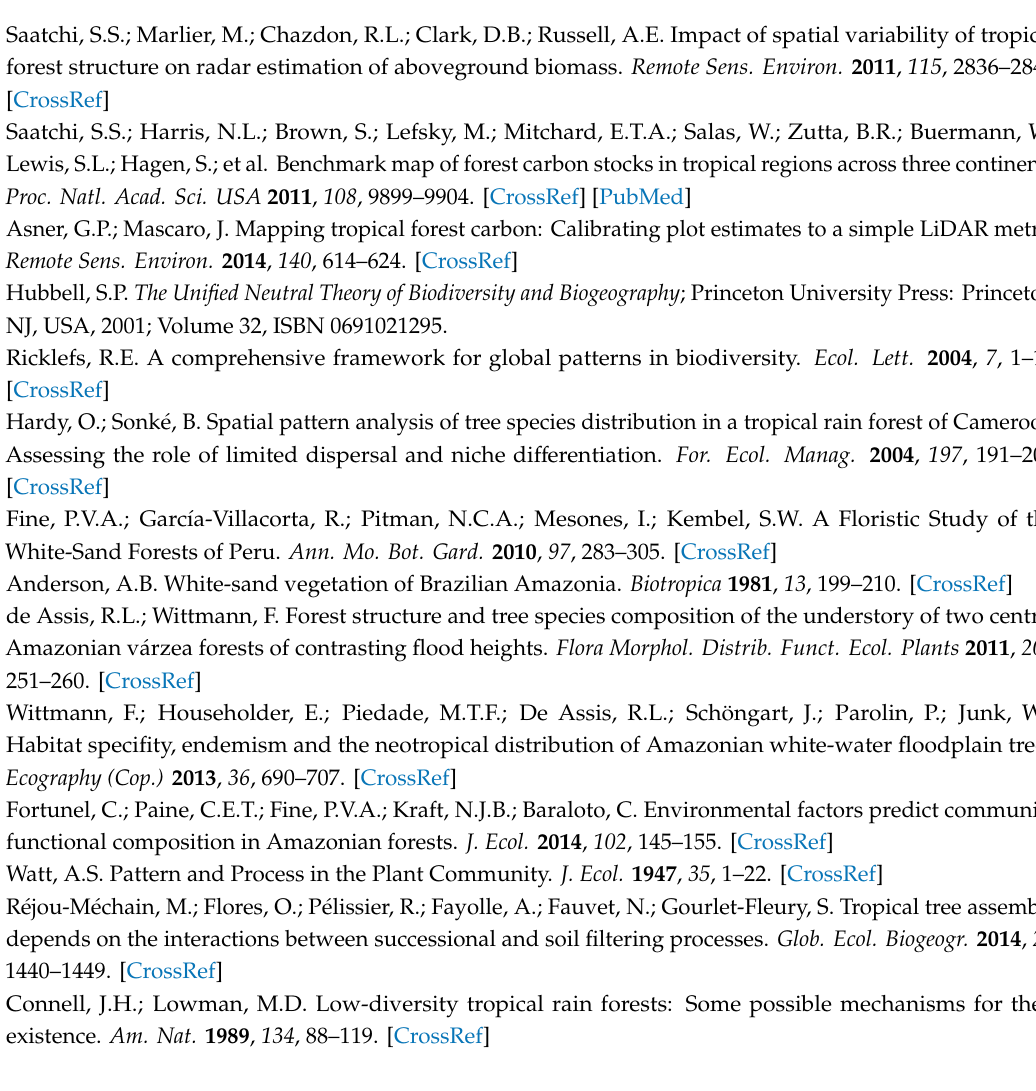
Table S1: Summary of topography and forest attributes collected from 30 1-ha plots in the tropical forest in the Uma forest of the Congo